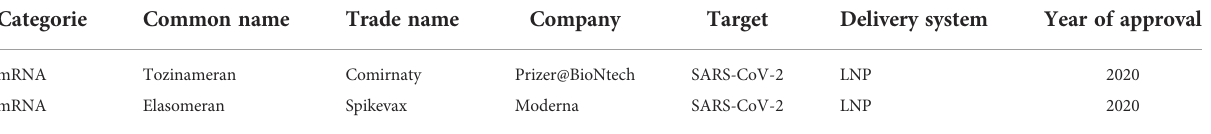
TABLE 1 Global marketed mRNA products.